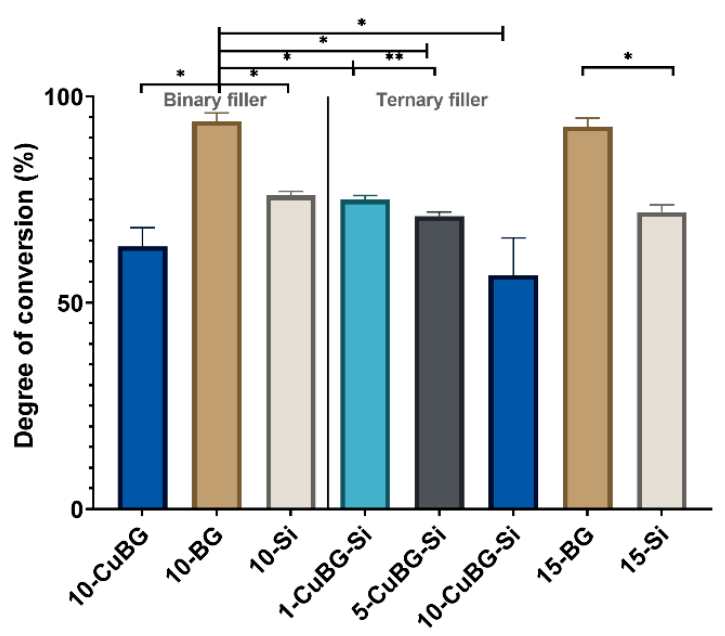
Figure 8. Degree of conversion of the Binary filler and the Ternary filler group after polymerization. Three samples from each group (n = 3) were used for analysis. Error bars represent standard deviations. An asterisk indicates statistically significant differences (* p < 0.01, ** p < 0.001).